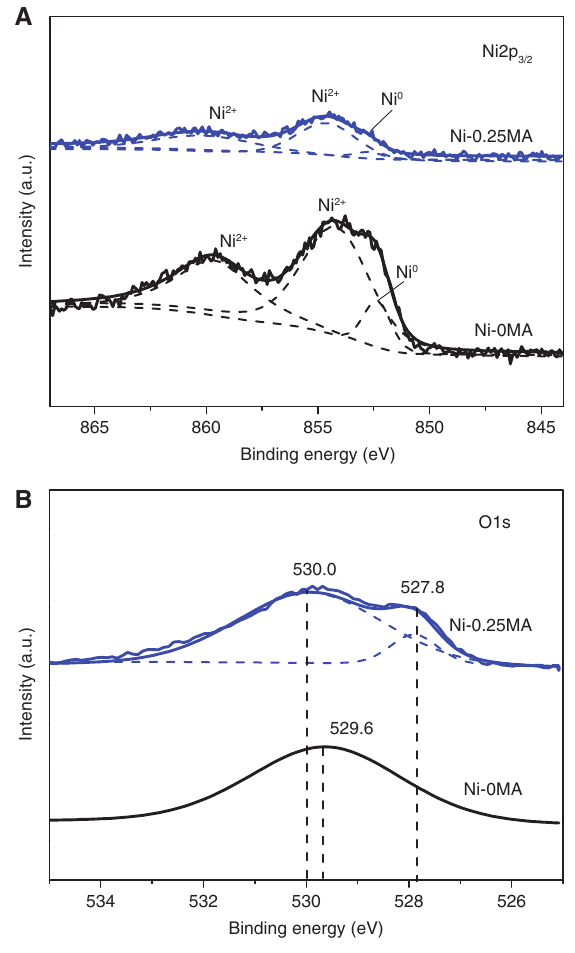
Figure 7: Spectra of the reduced Ni-0MA and Ni-0.25MA catalysts. (A) The Ni 2p spectra of the reduced Ni-0MA and Ni-0.25MA catalysts; (B) the O 1s spectra of the reduced Ni-0MA and Ni-0.25MA